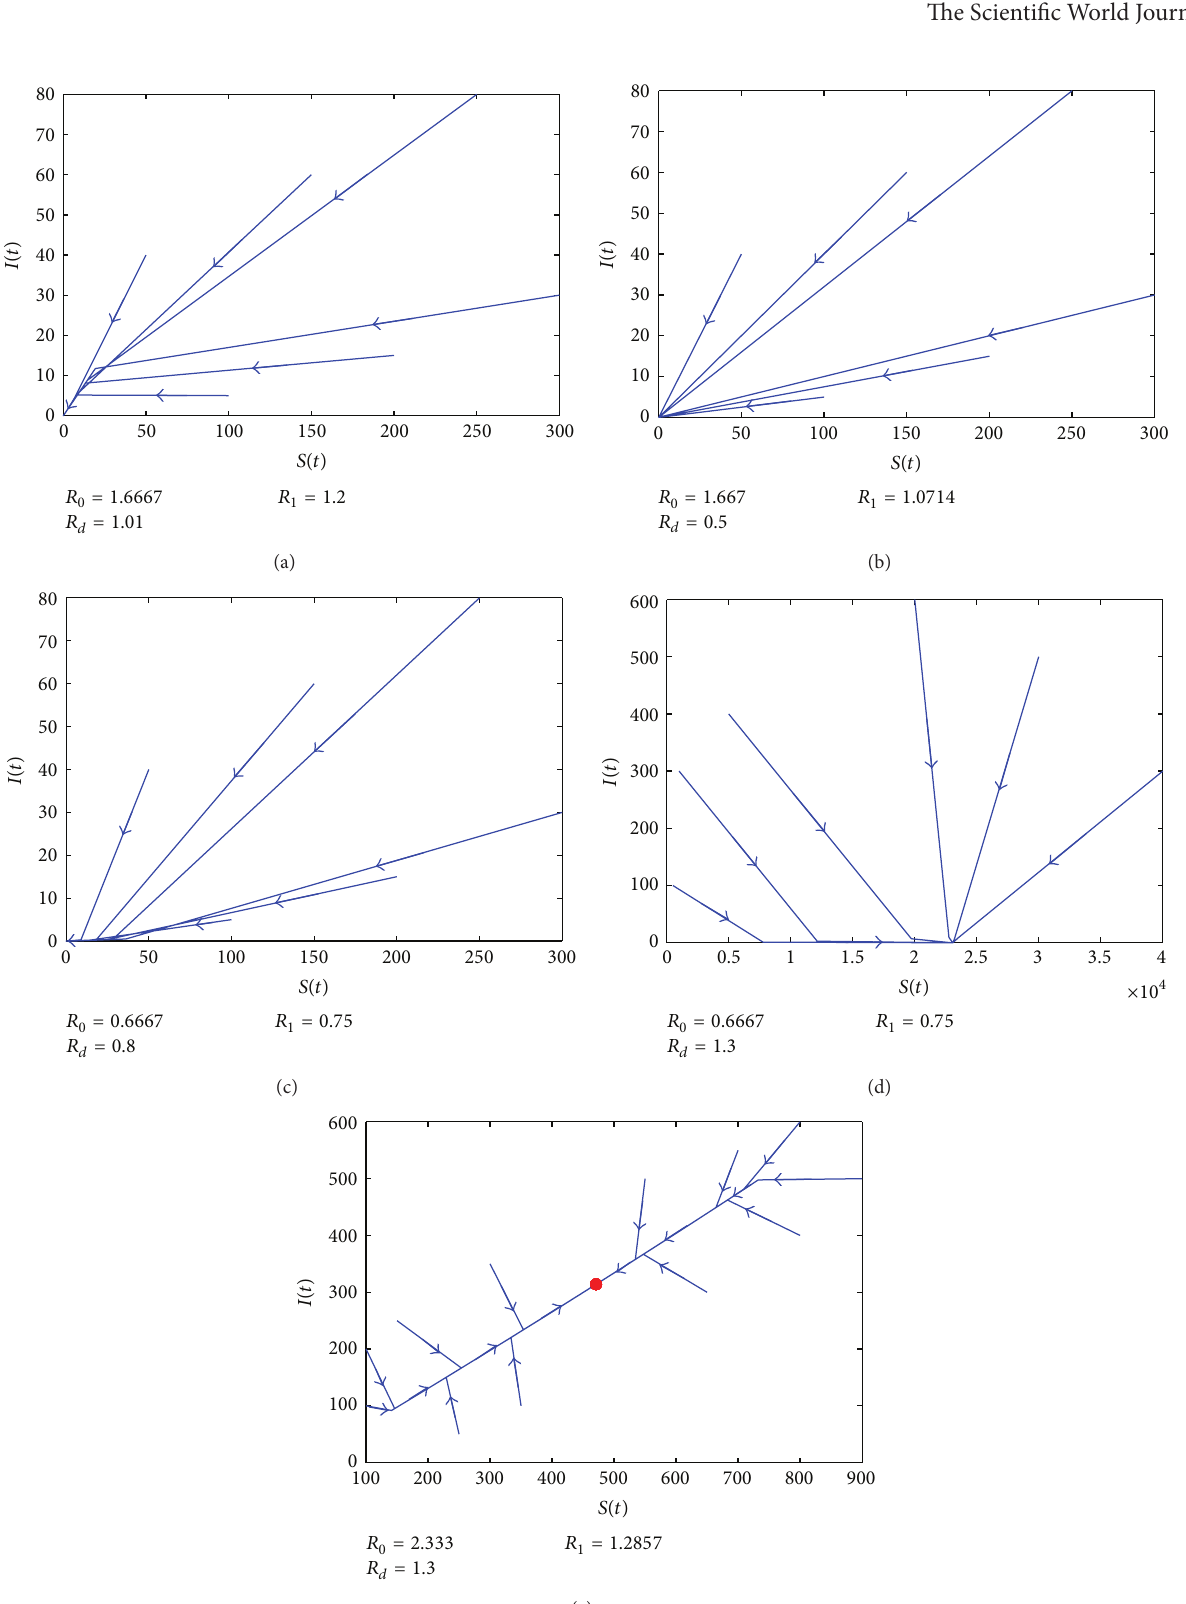
𝑟 = 0.08 and 𝛽 = 0.2 ; (d) in the region 𝐸 1 with